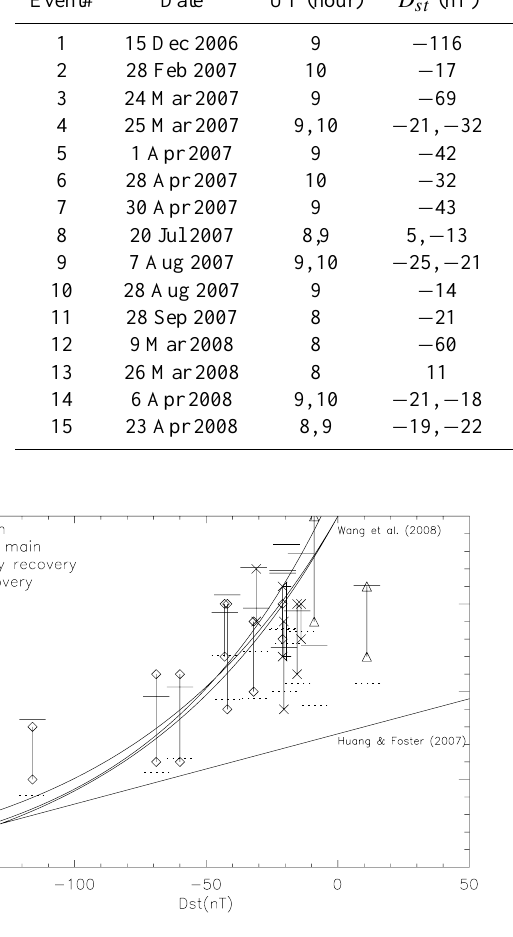
Fig. 4. Latitudinal extent of westward flow enhancement. Empir- ical SAPS locations as estimated by Huang and Foster (2002) and Wang et al. (2008) are also shown as a function of D st . Horizontal solid and dotted lines show the low-latitude boundaries of auroral electron precipitation and trapped ring current